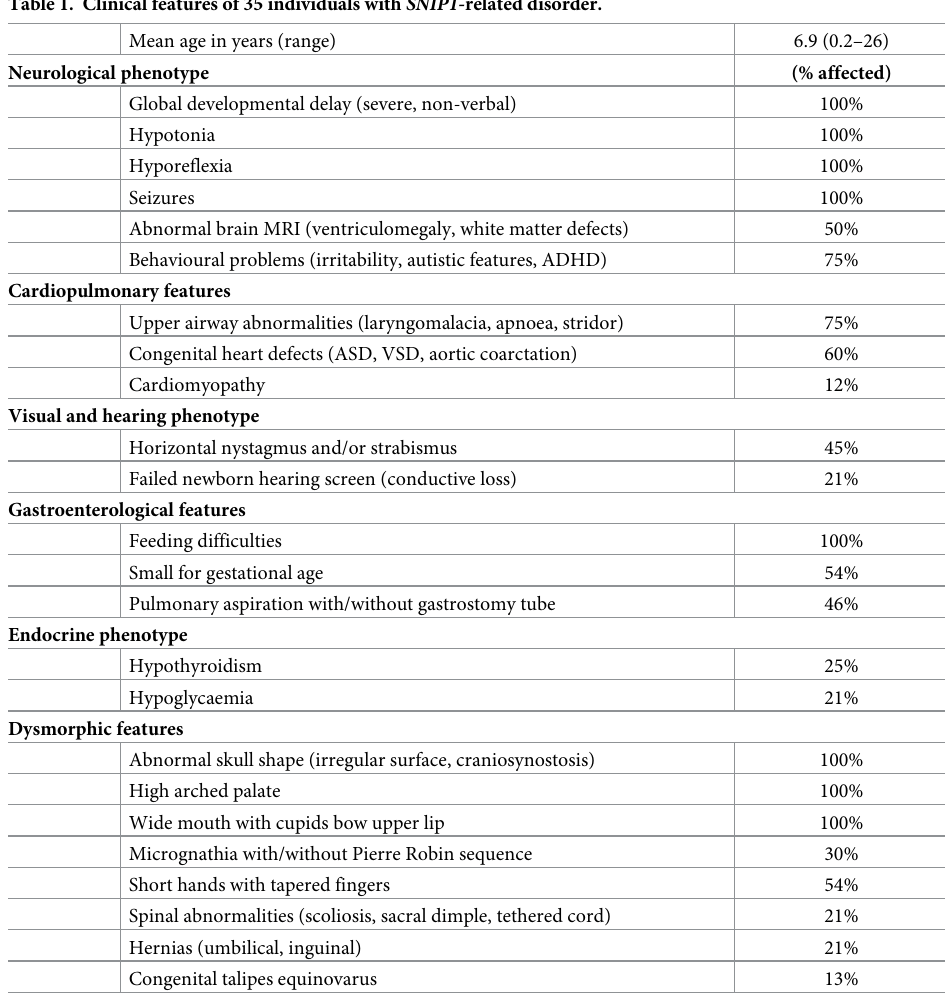
Table 1. Clinical features of 35 individuals with SNIP1 -related